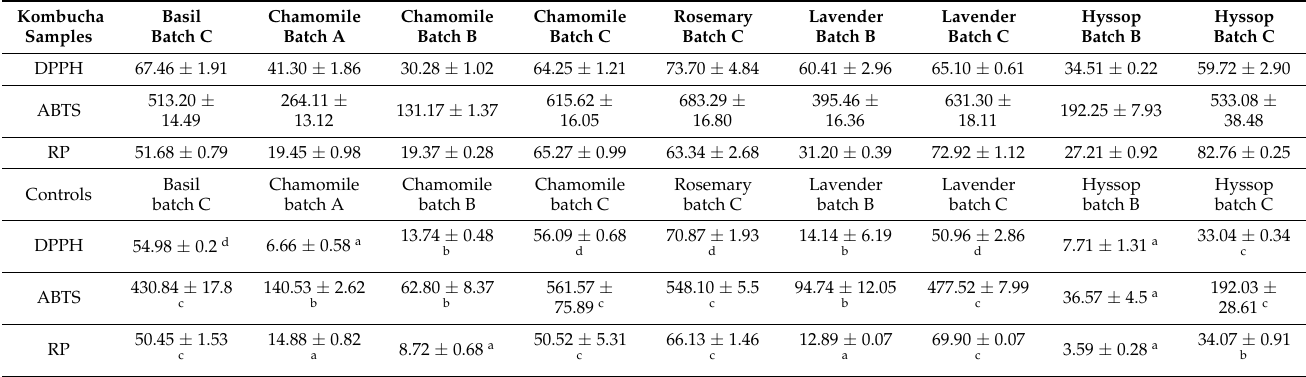
Table 4. Antioxidant capacity (mmol TE/100